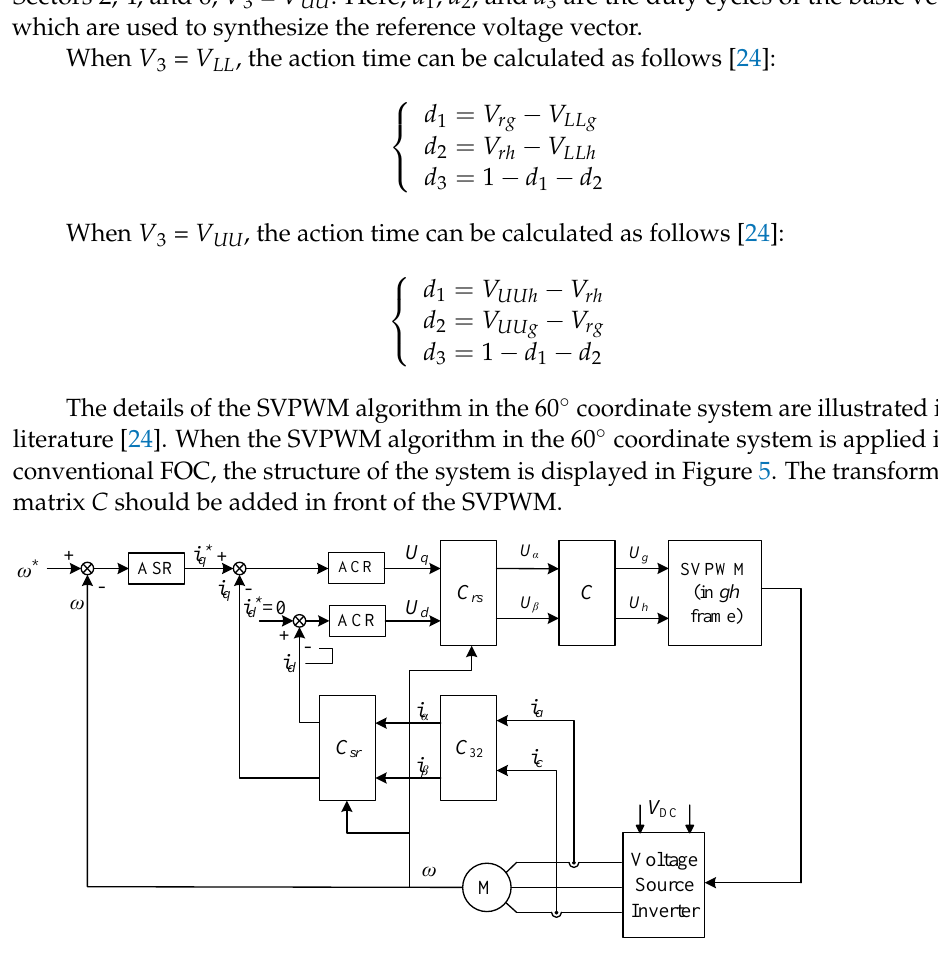
Figure 5. FOC with the SVPWM in the 60° coordinate system.